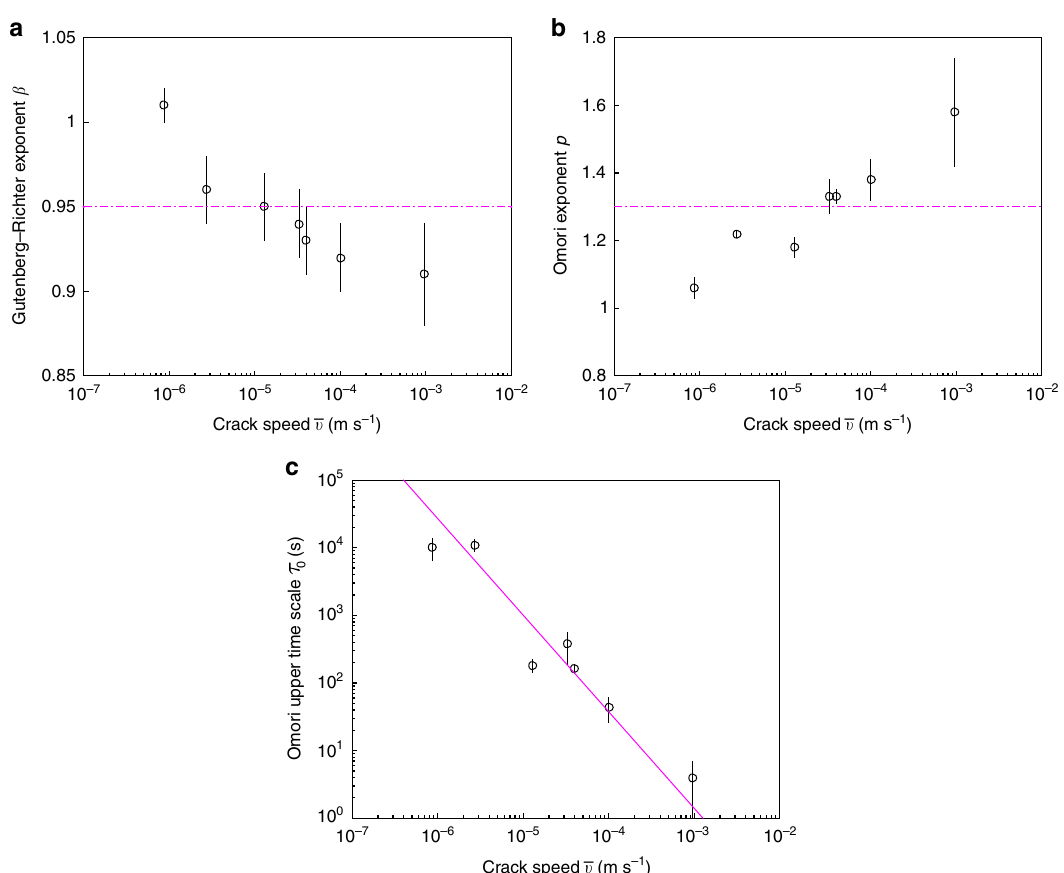
Fig. 4 Effect of crack speed. a Variation of the Gutenberg – Richter exponent β as a function of the mean crack speed (cid:1) v . The horizontal magenta dash line indicates the mean value: (cid:1) β ¼ 0 : 95. b Variation of the Omori – Utsu exponent p as a function of the (cid:1) v . The horizontal magenta dashed line shows the mean value: (cid:1) p ¼ 1 : 3 c variation of the upper time scale τ 0 associated with the rescaled Omori – Utsu law (Eq. 4). Straight magenta line is a power-law fi t with exponent (cid:2) 1 = ð 2 (cid:2) (cid:1) p Þ . a , b x -axis is logarithmic. c both axes are logarithmic. In all panels, the errorbars stand for 95% con fi dence